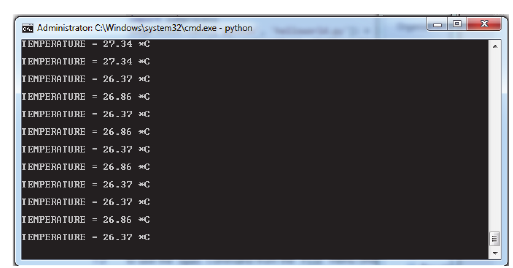
Figure 14: An example of a serial connection of a